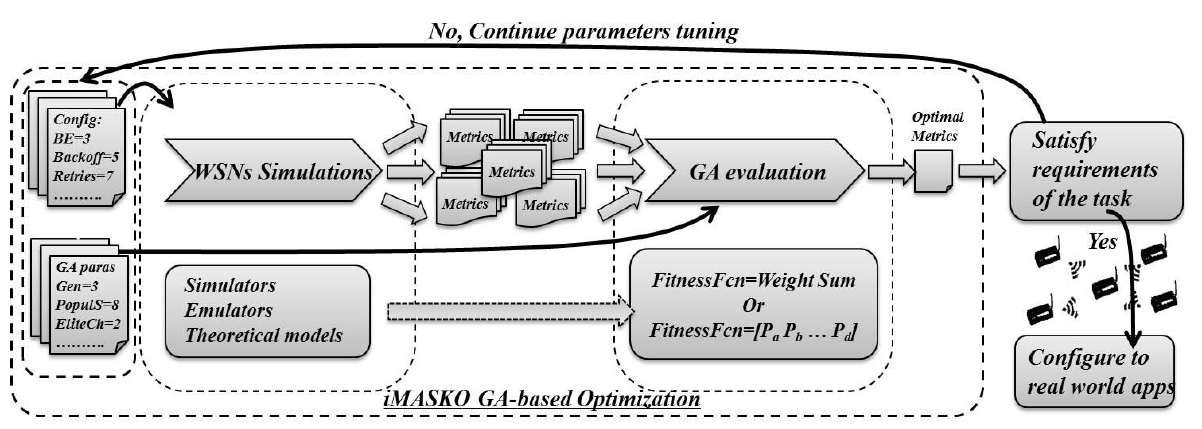
Figure 2. Workflow of iMASKO.